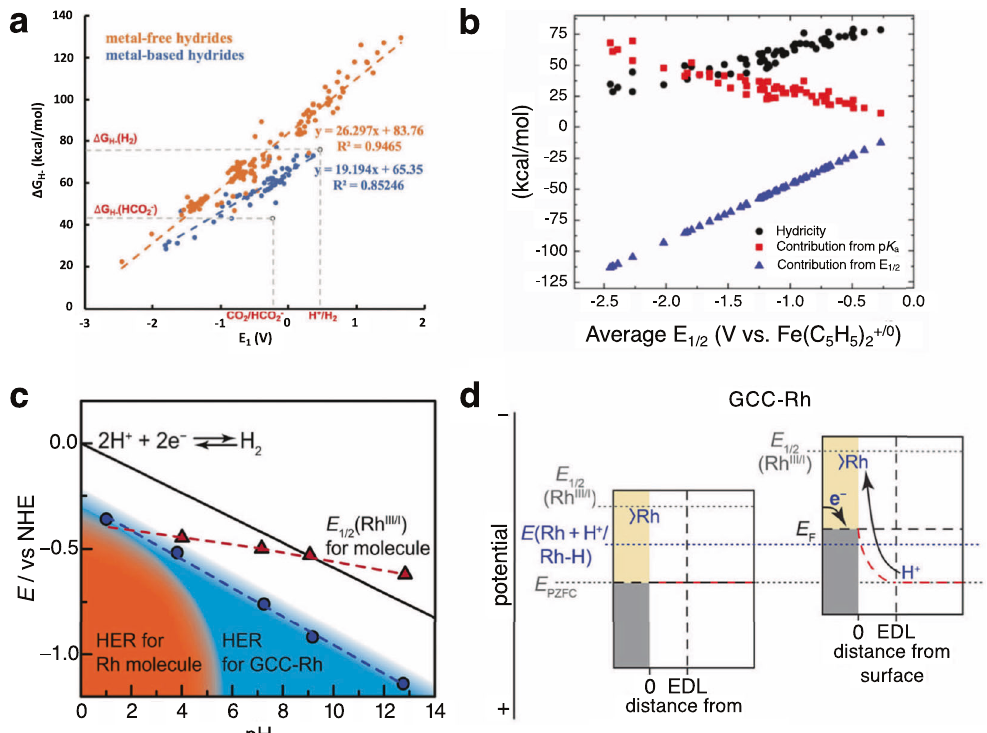
Fig. 5 Thermodynamic properties of molecular catalysts. a The scaling relationships between the thermodynamic hydricity ( Δ G ) and the fi rst reduction potential E 1 of the metal-free (orange) and metal-based hydrides (blue). Adapted and reprinted with permission from ref. 89 . b Two-electron redox potential (blue triangles) and pK a (red squares) contributions to Δ G (black circles) of metal hydrides plotted by their average redox potentials. Adapted and reprinted with permission from ref. 92 . c Pourbaix diagram for Rh molecular catalysts (red triangles) and Rh attached to glassy carbon electrode (GCC- Rh, blue circles). The black solid line denotes the thermodynamic potential of HER. The orange region denotes the potential-pH region in which the model is catalytically active, while the blue region shows conditions where GCC-Rh catalyzes HER 97 . d Proposed interfacial free energy diagrams for GCC-Rh electrodes. The gray area represents the fi lled band states of the electrode, while beige denotes the un fi lled band states. The dotted horizontal black line indicates the E F of the electrode. The electrical double layer, EDL, is labeled by a vertical dotted black line. The redox potential of the molecule ( E 1/2 (Rh III/I )) and the potential for formation of a Rh − H species at the GCC site (E(Rh + H + /Rh − H)) are illustrated with dotted gray and blue lines, respectively. The electrostatic potential is shown with the dotted red line, and the potential of zero free charge (EPZFC), is indicated with a dotted gray line. Adapted and reprinted with permission from ref. 97 , https://pubs.acs.org/doi/full/10.1021/jacs.9b04981. All future permission should be directed to the